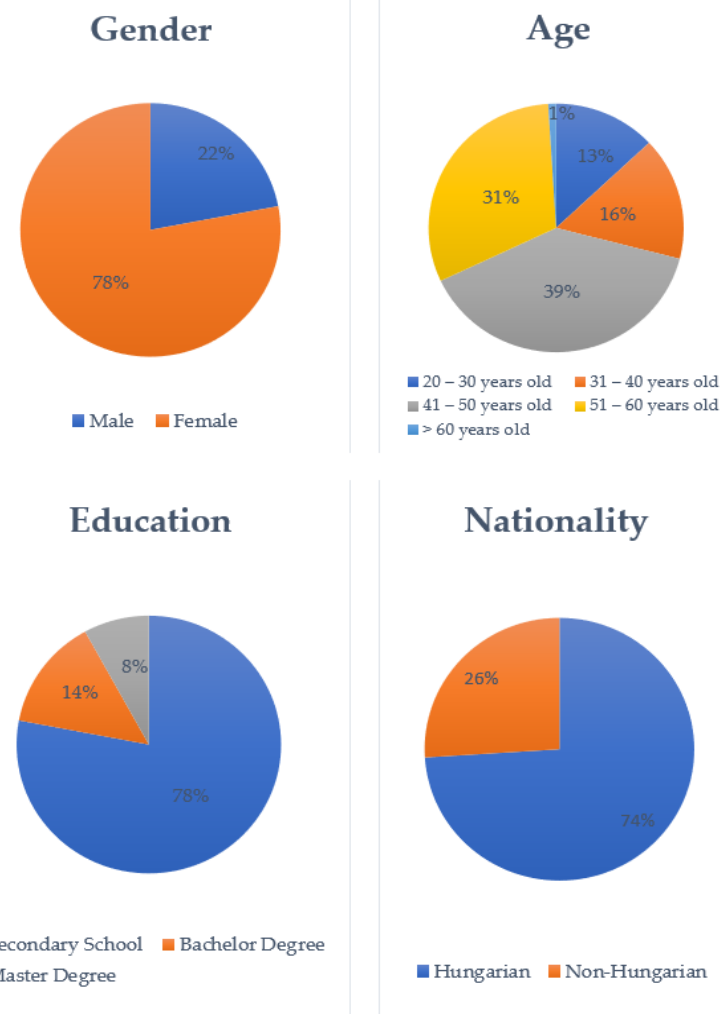
Figure 2. Number of questionnaire respondents based on gender, age, education and nationality.